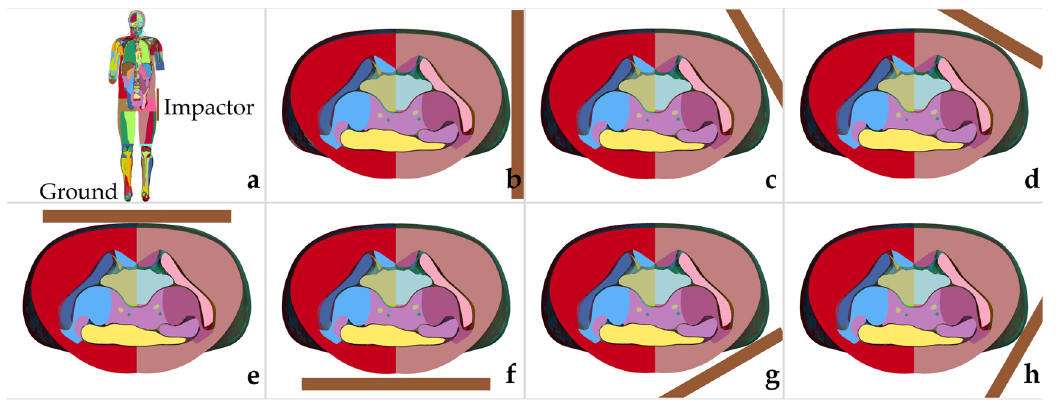
Figure 4. Pelvic impact loading conditions. ( a ) Vertical positions of the plate impactor; ( b – h ) represent the impact directions of 0°, 30°, 60°, 90°, 270°, 300° and 330°, respectively.